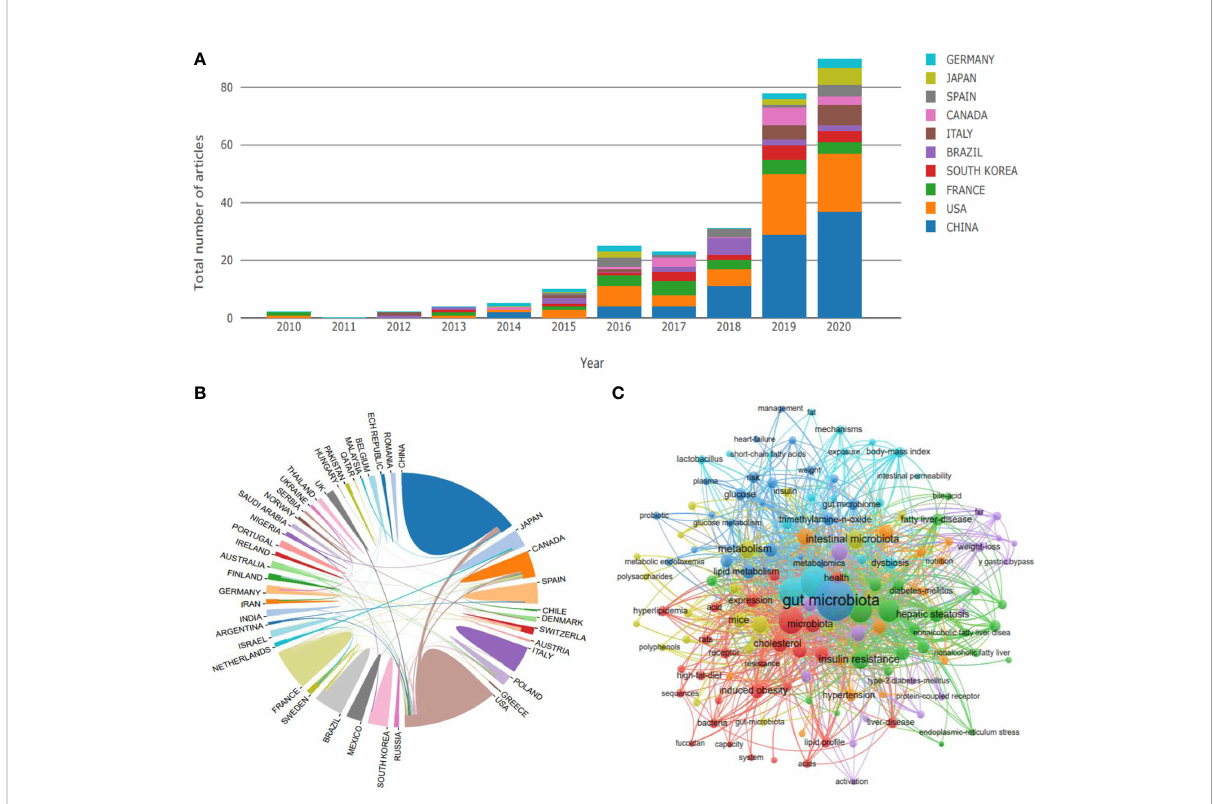
FIGURE 1 Research trend of the gut microbiota regulating dyslipidemia. (A) The number of published papers over the years includes the distribution of countries, (B) State relations, (C) Related